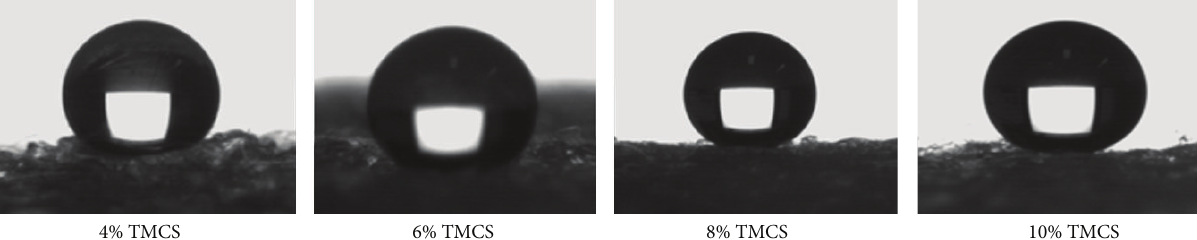
Figure 5: Photographs showing a water droplet on the surface of silica aerogel blankets obtained at different concentrations of TMCS.